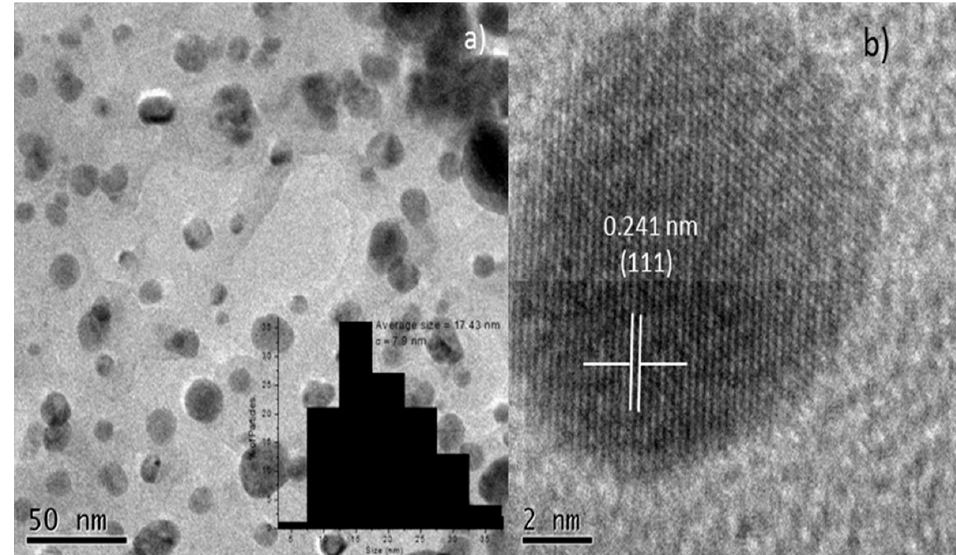
Figure 3. ( a ) TEM image of Ag NPs, inside histogram of size nanoparticles; ( b ) HRTEM image of a Ag-NP.